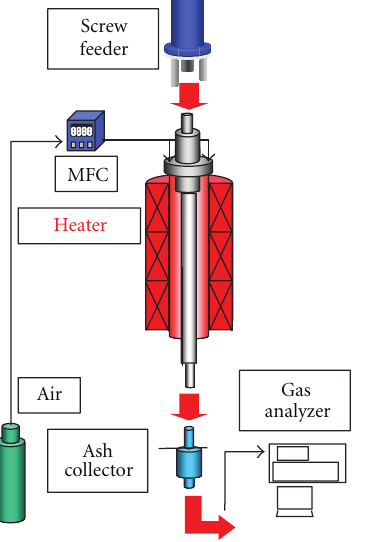
Figure 2: Schematic diagram of the DTR.